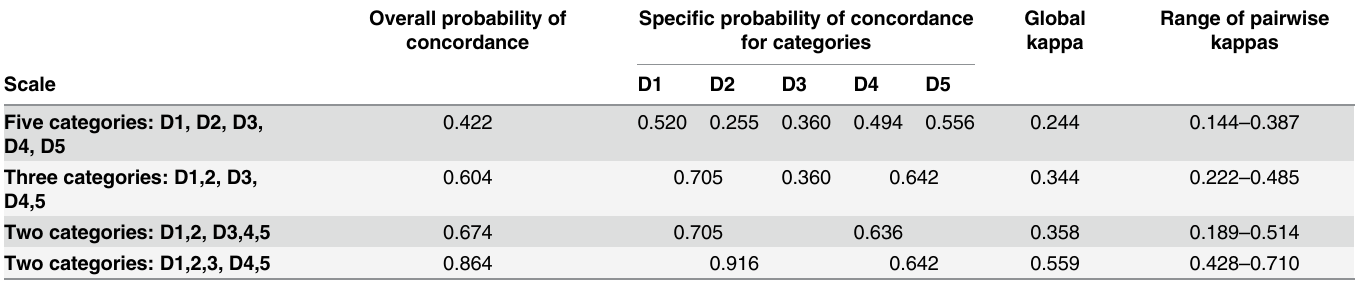
Table 2. Agreement statistics for Deauville (D) scoring among five readers.